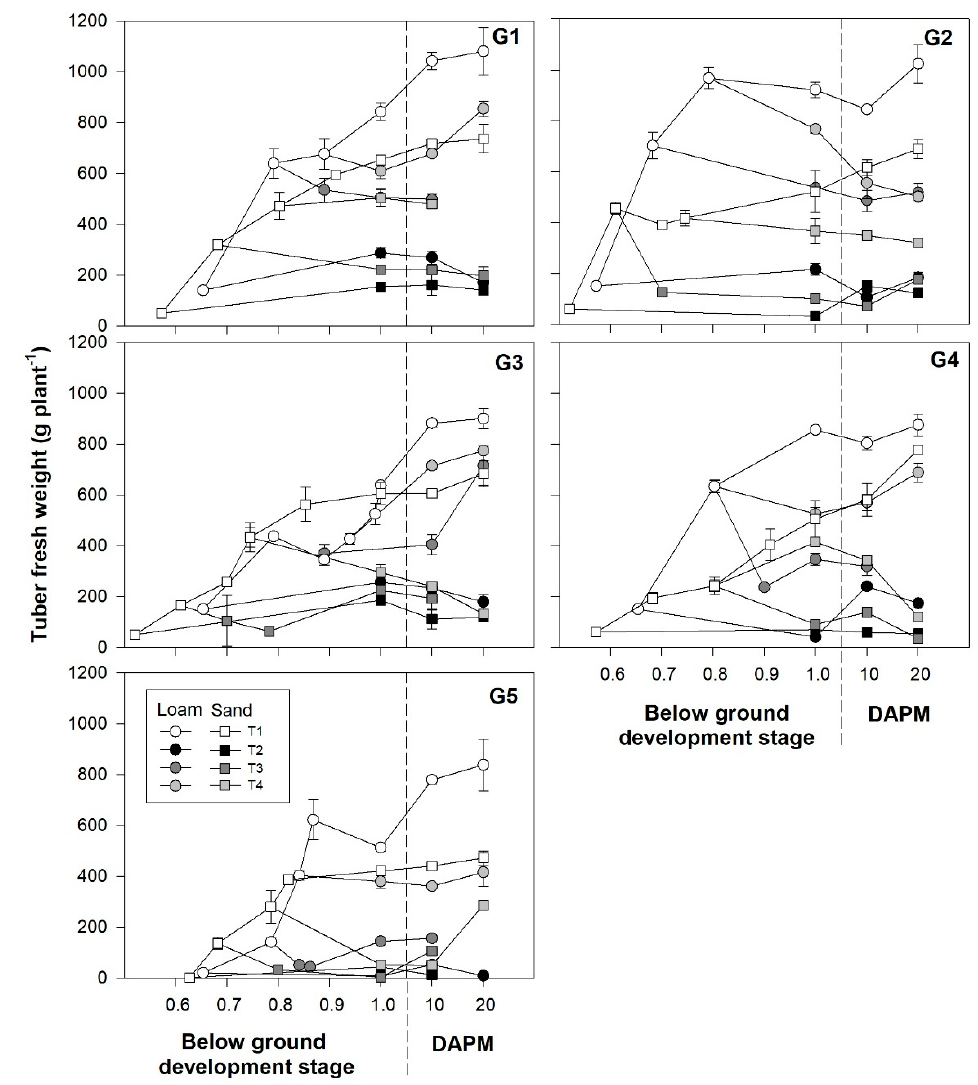
Figure 5. Tuber fresh weight dynamics and below ground phenology of five potato clones grown on two soil types under four irrigation treatments. Treatment details are given Table 2. Additional destructive samplings 10 or 20 days after the stage of physiological maturity (DAPM) were included where applicable. Error bars = Standard error (n = 3).